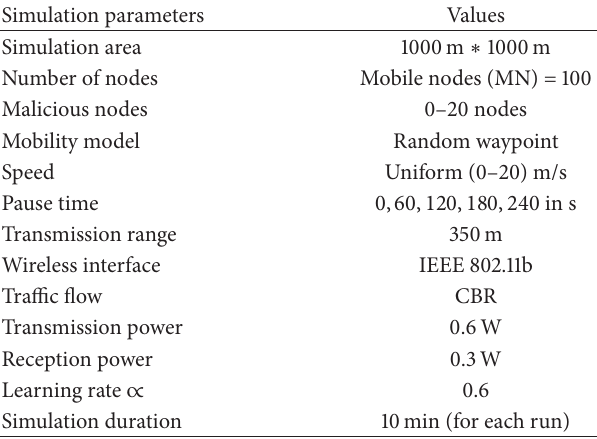
Figure 5: Flow diagram of route discovery phase in QTABR. Table 2: Summary of NS-2 simulation